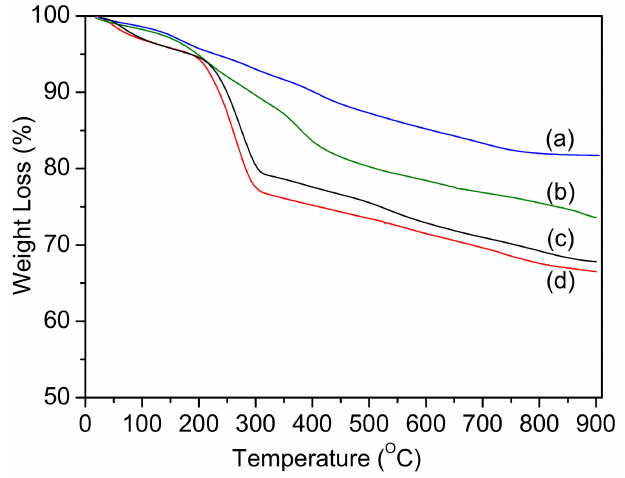
Figure 4. TGA curves of Fe 3 O 4 @MSN-NH 2 (with CTAB) (c), Fe 3 O 4 @MSN-Br (with CTAB) (d),